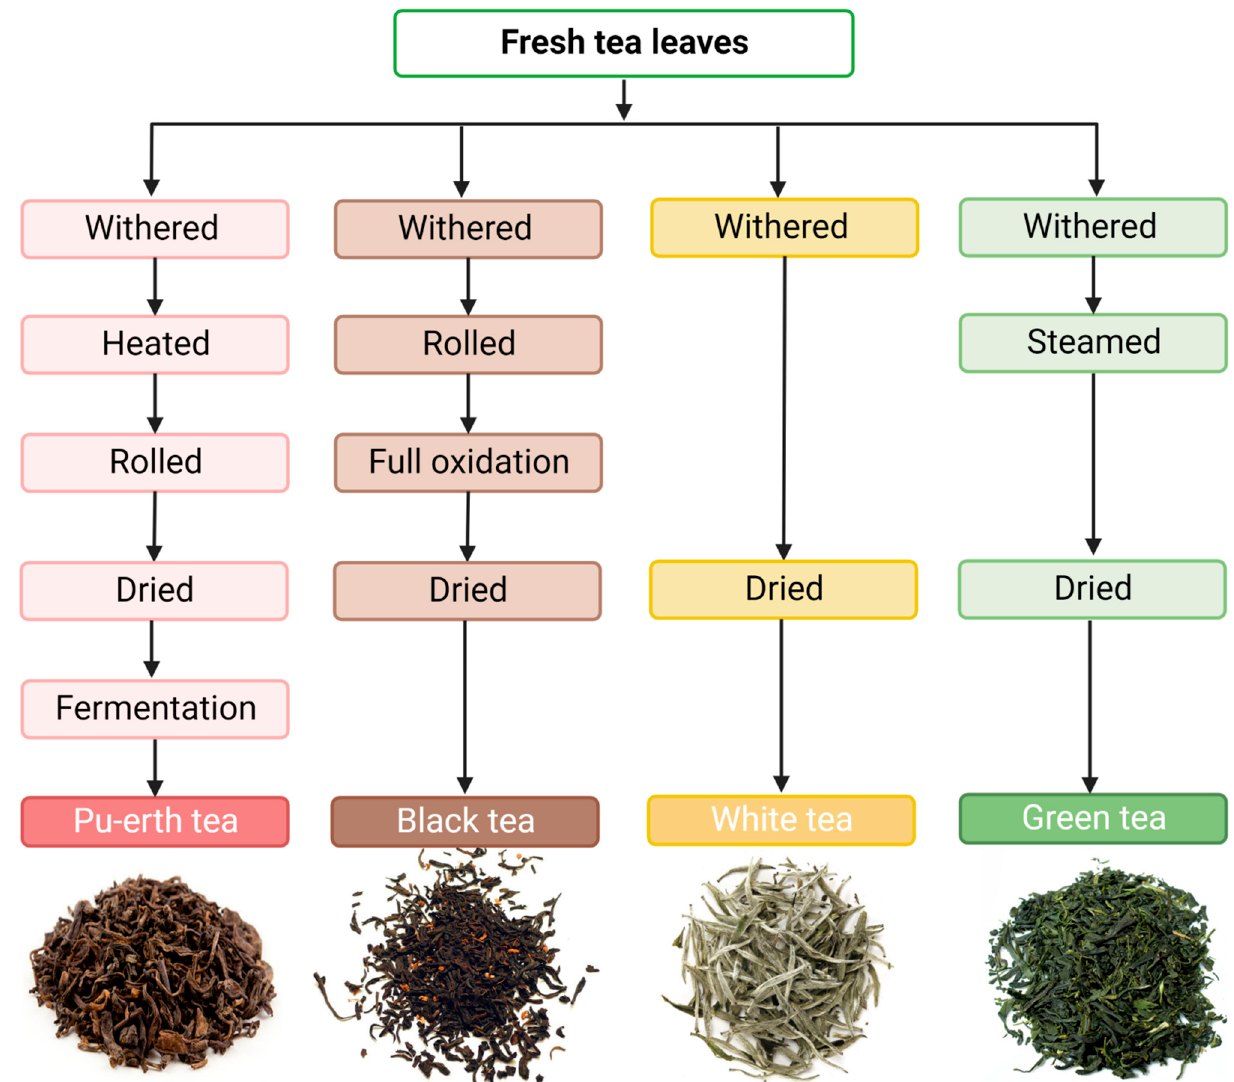
Figure 3. Types of teas and their production process. Created with BioRender.com.